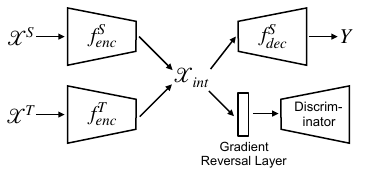
Figure 5. Partial Cycle-GAN approach for appearance adaptation. The generator G S → T tries to fool the discriminator, i.e., ideally the set of generated instances X S → T looks indistinguishable from X T .